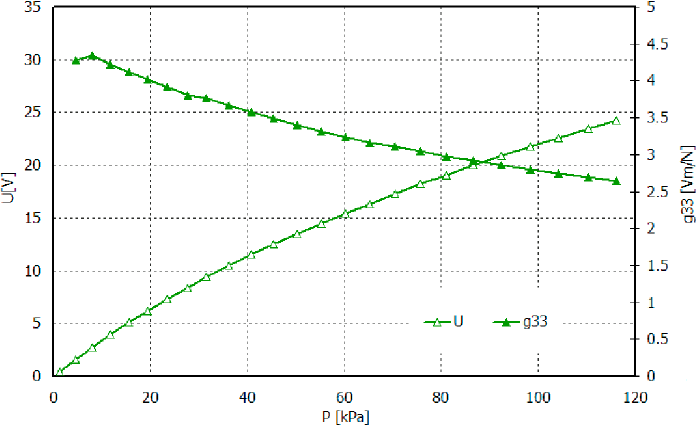
Figure 10. Dependence of tension and piezoelectric coe ffi cient g 33 vs. mechanical stress for composite HDPE + 10% Sillikolloid